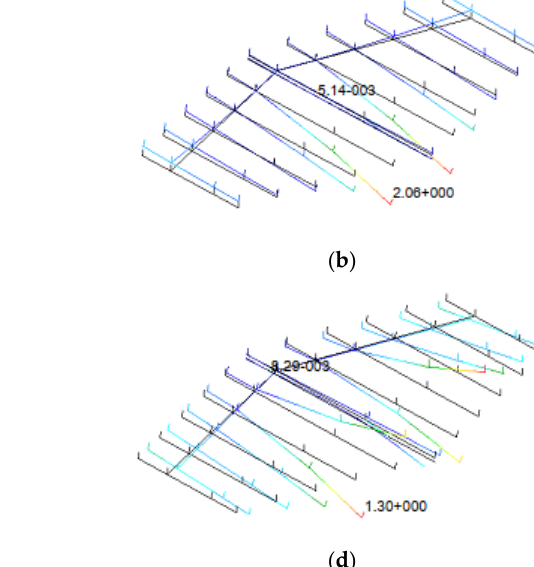
Figure 6. Fuselage component modal shape of first four elastic modes. ( a ) 1st order mode, symmetric. ( b ) 2nd order mode, symmetric. ( c ) 3rd order mode, asymmetric. ( d ) 4th order mode, asymmetric. Table 4. Fuselage component mode analysis results. Table 3. Wing component mode analysis results.